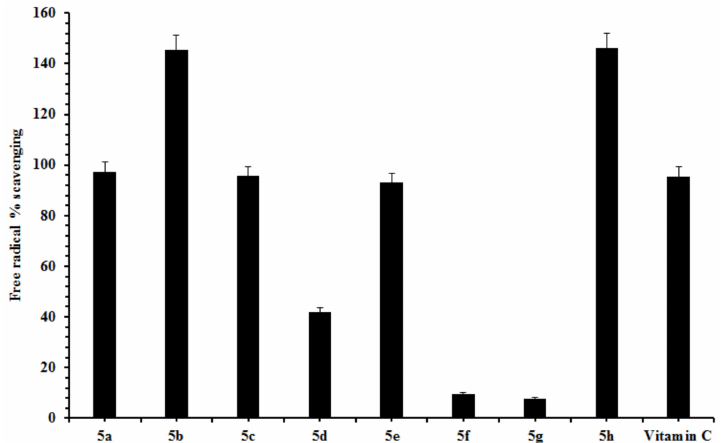
Figure 3. Free radical scavenging activity (%) of the synthesized compounds; values are presented as the mean ± SEM. All compound concentrations were 100 µ g /